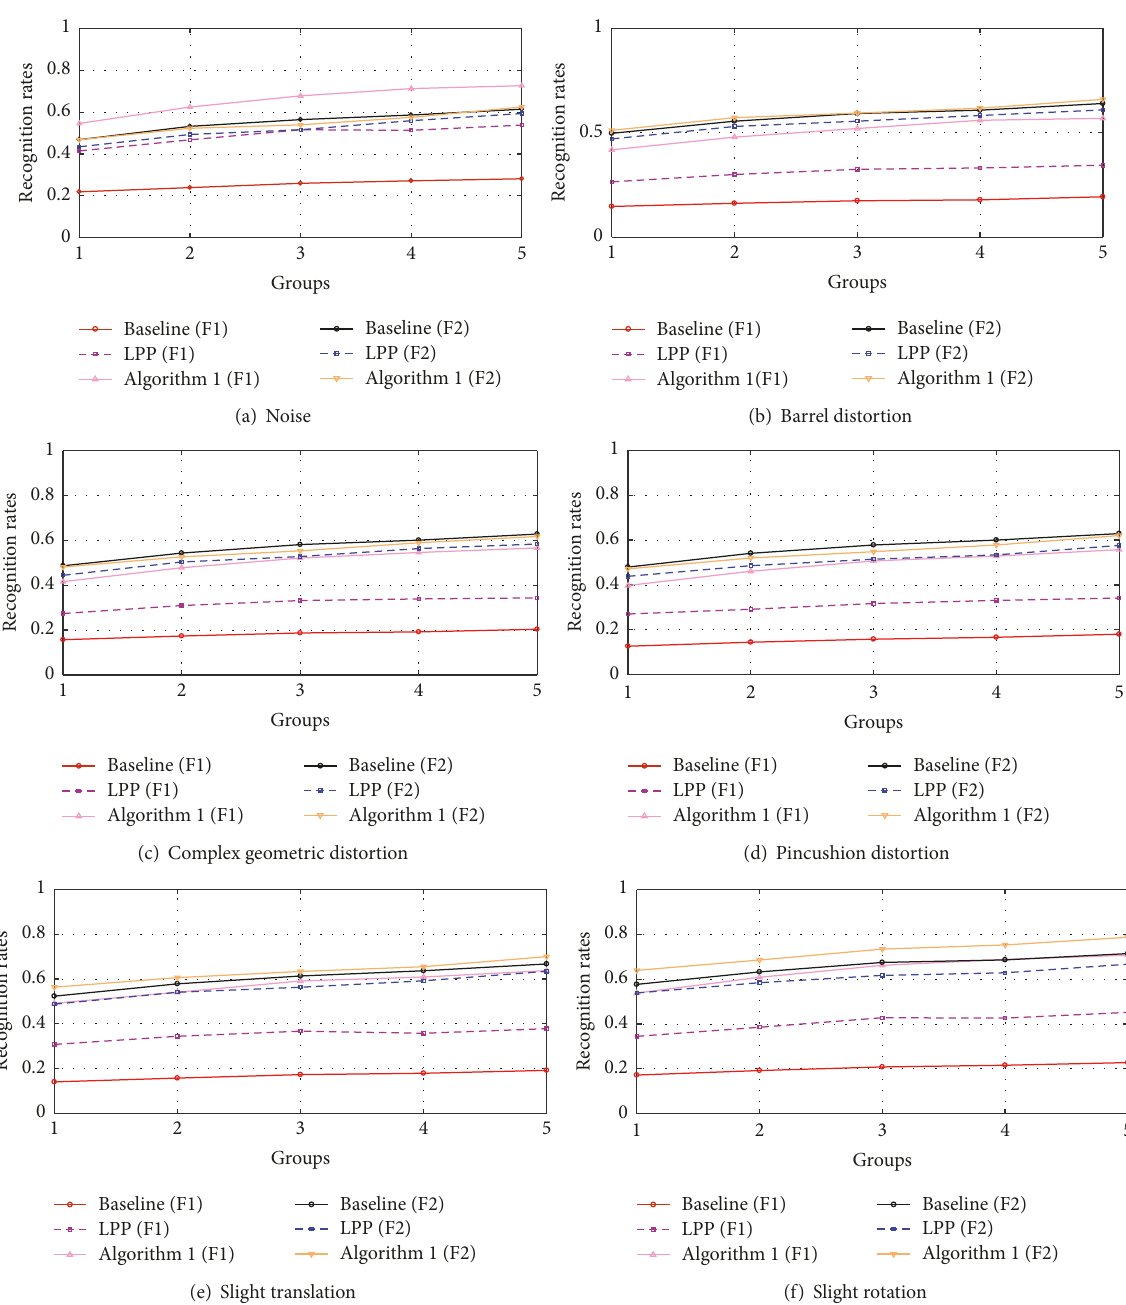
Figure 10: The recognition rates on noise, geometric distortion, slight translation, and slight rotation AR face databases over “F1” and “F2”